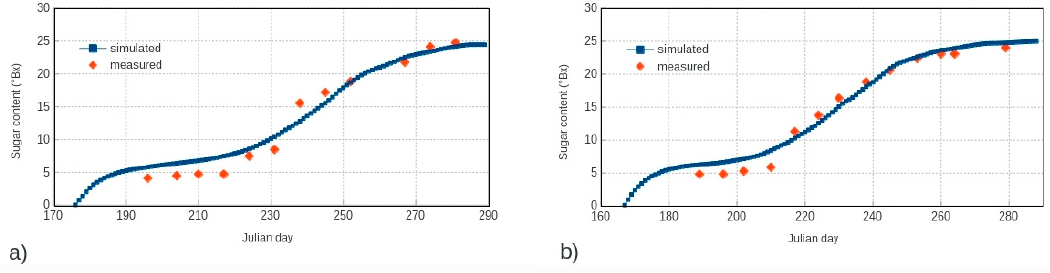
Figure 4. Comparison between simulated and measured berry sugar content (°Bx) in the Castagnito site during 2004 ( a ) and 2005 ( b ). Table 4. Comparison between simulated and measured values of LAI , berry weight, and sugar content at Fubine. MAE: Mean absolute